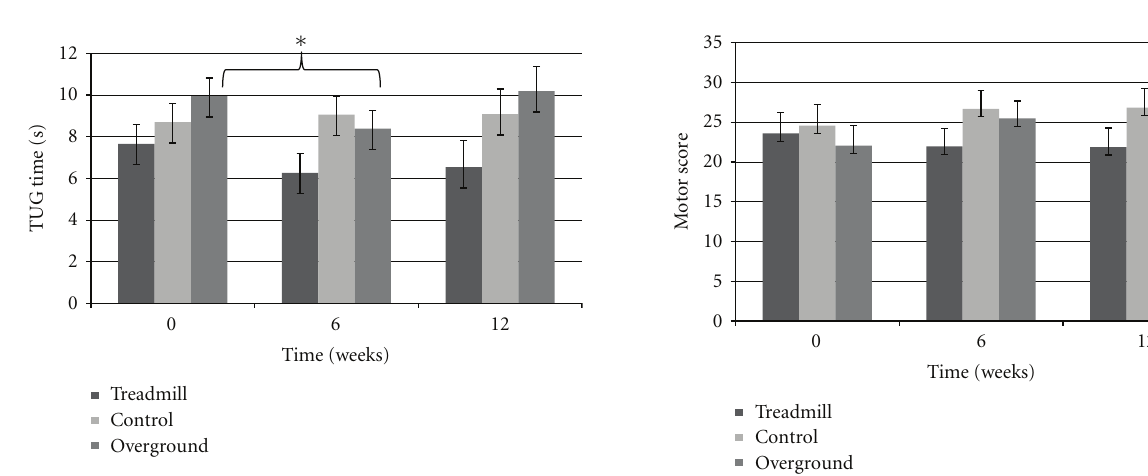
Figure 3: Examination of TUG times reveals a short-term main e ff ect in PD OG. Figure 4: Motor scores showed at trend in improving symptoms in the TG, while the OG and CG seem to worsen